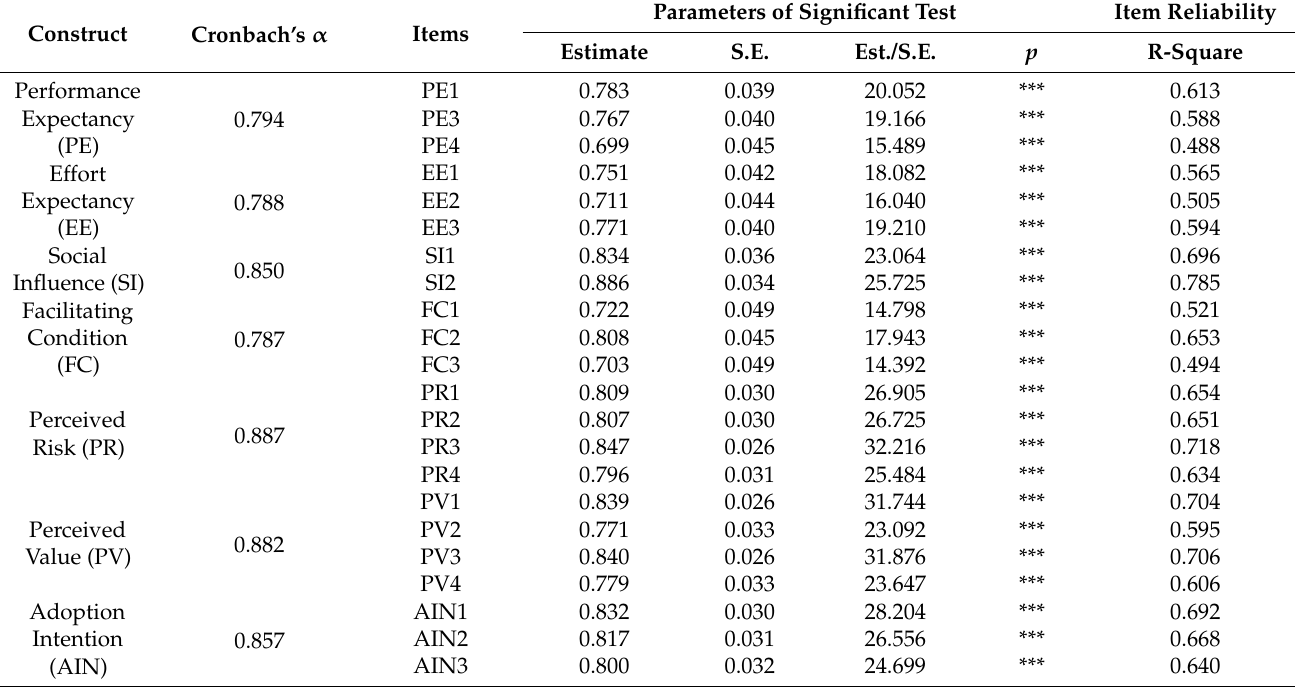
Table 3. Standardized item loading and reliability.